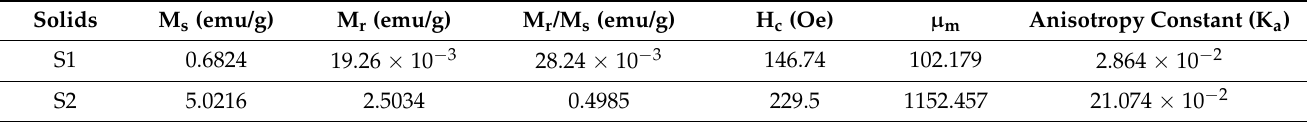
Table 2. Magnetic properties (M s , M r , M r /M s , K a , µ m and H c ) of the as-prepared